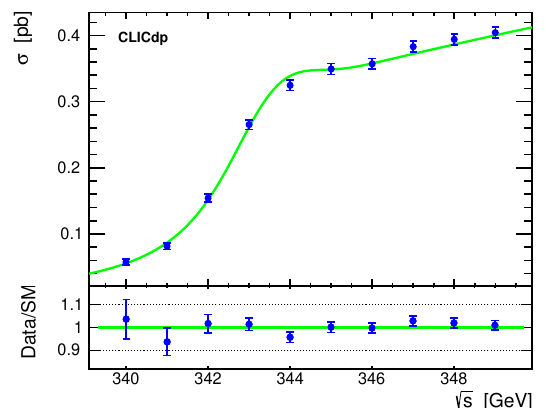
Figure 4 . Reference scenario for the top-quark threshold scan. The error bars on the simulated data points show the expected statistical uncertainties of the cross section measurements assuming integrated luminosity of 10 fb − 1 per